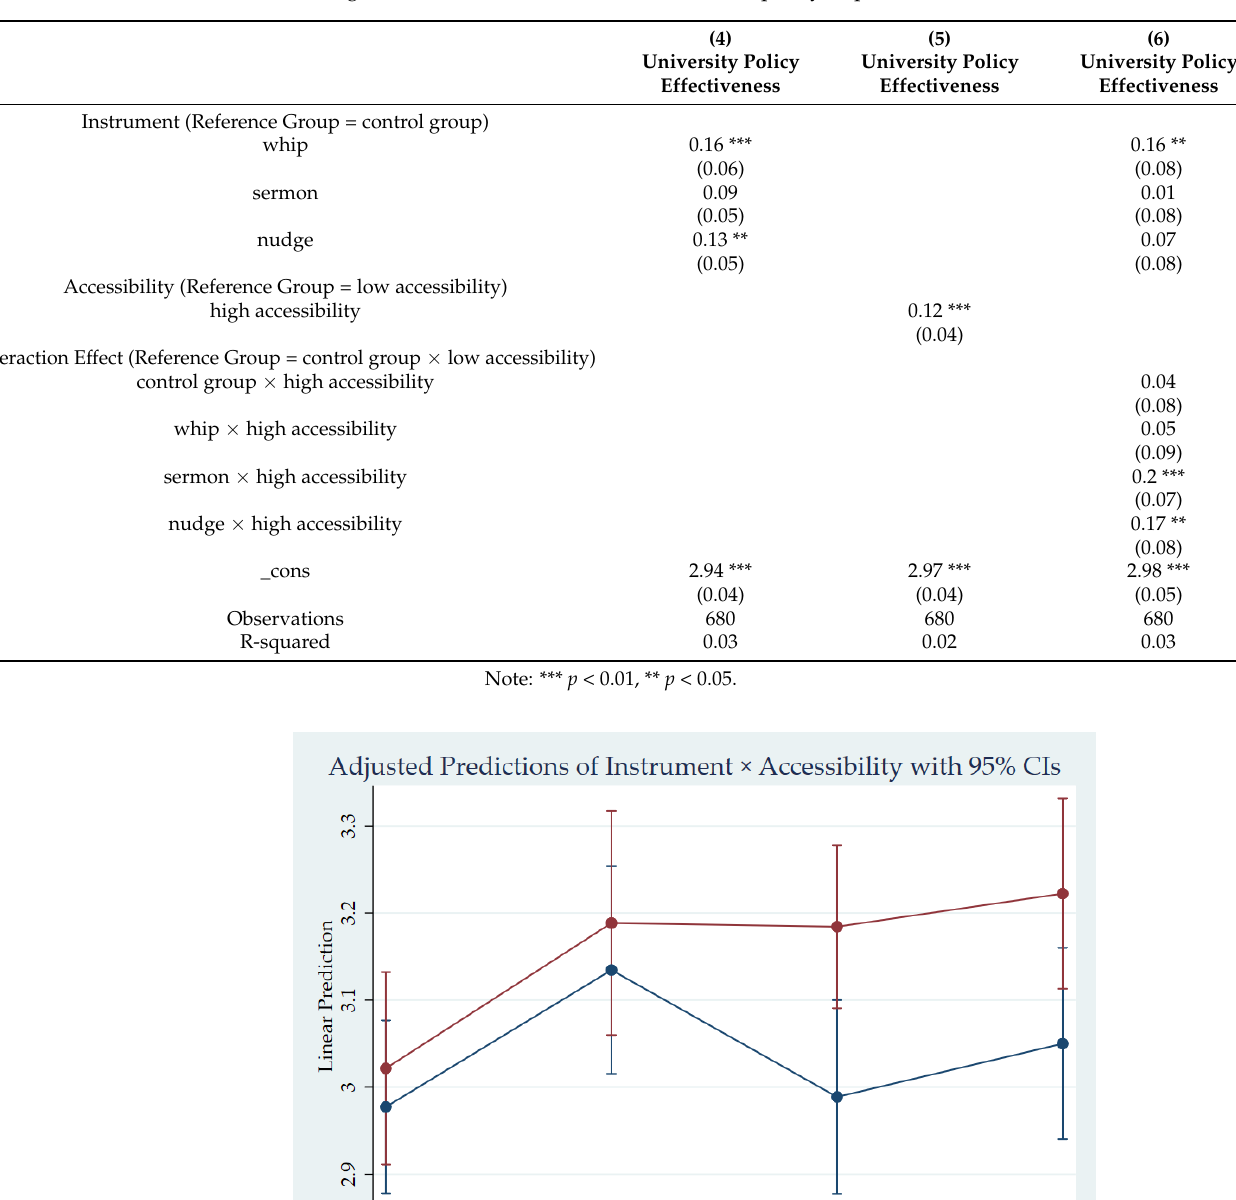
Table 4. Regression results of the effectiveness of the policy implementation.